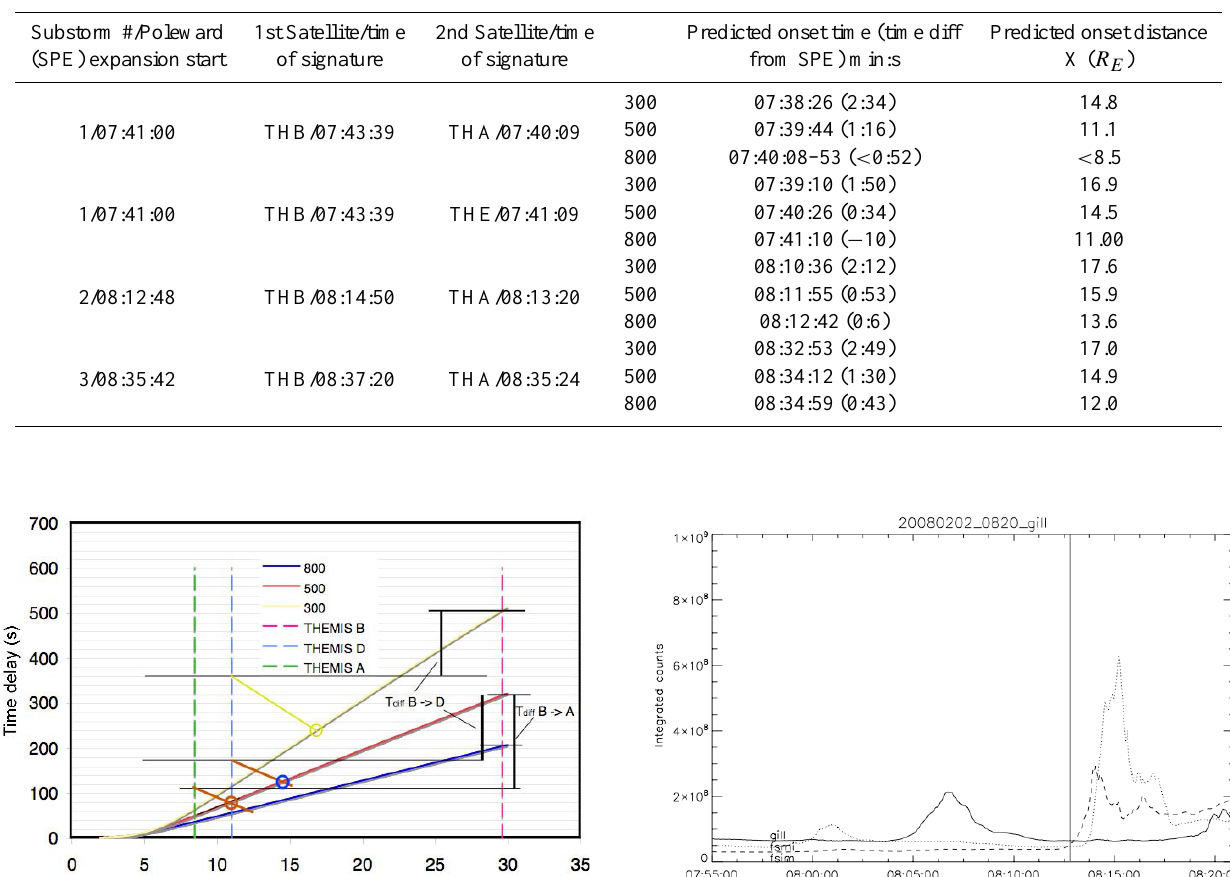
Table 1. Timing results from 3 substorms on 2 February 2008. First column shows substorm number designation and ground based determination of time of Substorm Poleward Expansion (SPE) onset or step 4. Second and third columns THEMIS satellite designator and time of arrival of magnetic impulse. Fourth column is the assumed ionoacoustic speed for the calculations. Fifth and sixth columns are the computed time (time delay to SPE in minutes and seconds) and x distance of the “point of origin” of magnetic impulse from earth respectively.